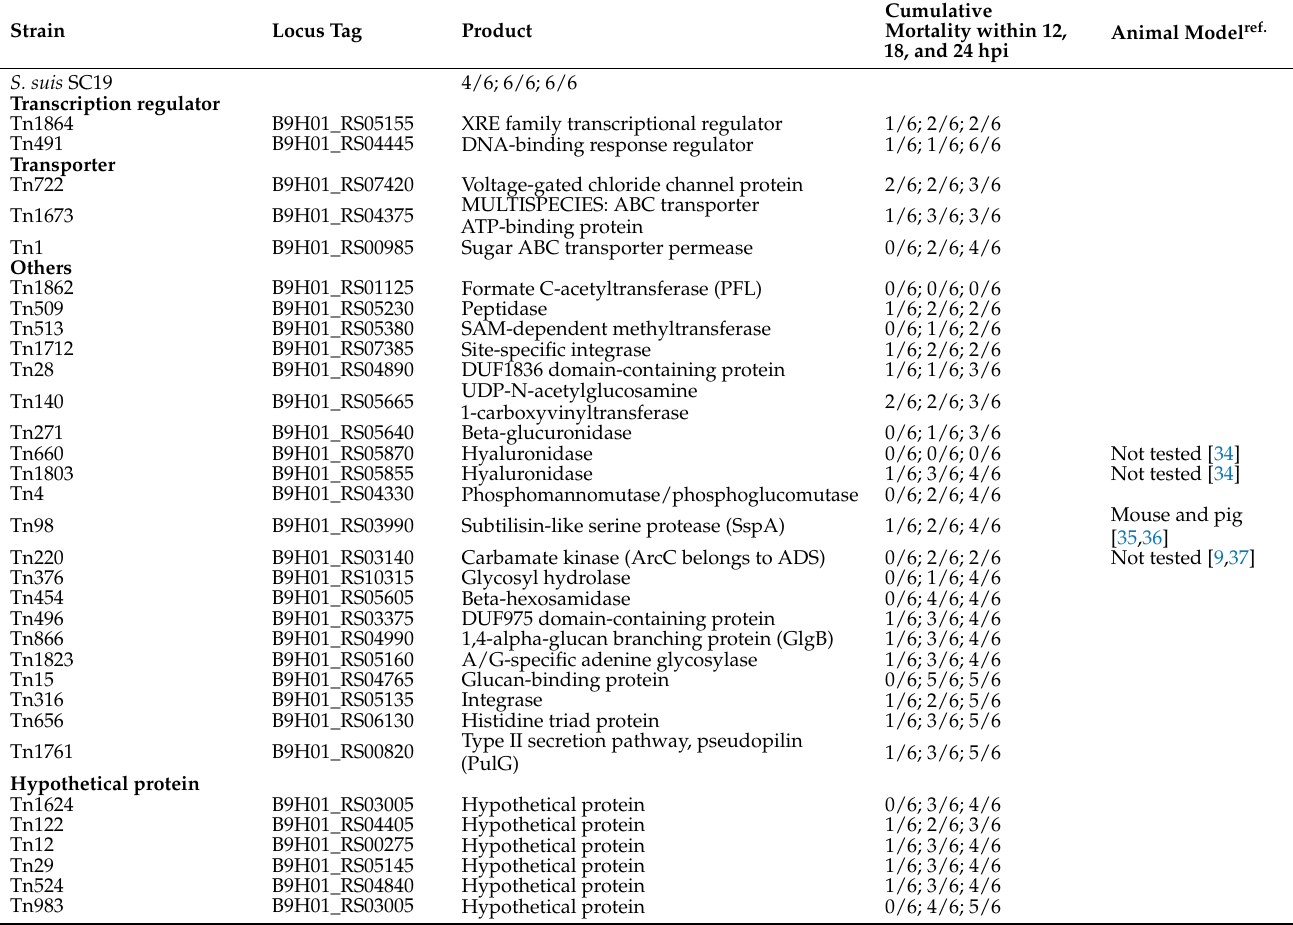
Table 2. Transposants with reduced virulence in Galleria mellonella